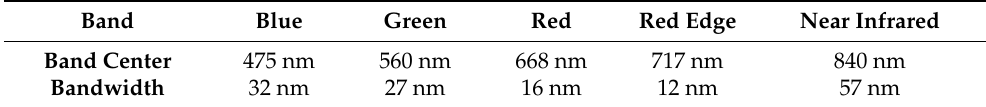
Figure 2. Field-collected images of the classes at the study site. The images analyzed in this study were acquired in August 2020. A Parrot Disco fixed-wing UAS (Paris, France) was modified to house a MicaSense RedEdge-MX sen- sor (Seattle, WA, USA). This sensor measured five spectral bands: blue, green, red, red edge, and near infrared (Table 1). The data were processed in Pix4D (Prilly, Switzerland), which stitched the imagery together using image overlap to produce a color-balanced orthomosaic. The image dimensions were approximately 8000 pixels × 15,000 pixels × 5 bands with a 7.6 cm spatial resolution in the 16-bit TIFF image format. The orthomosaic covered approximately 60 hectares. Figure 3 shows an example of each land cover class in the orthomosaic. Table 1. RedEdge-MX sensor